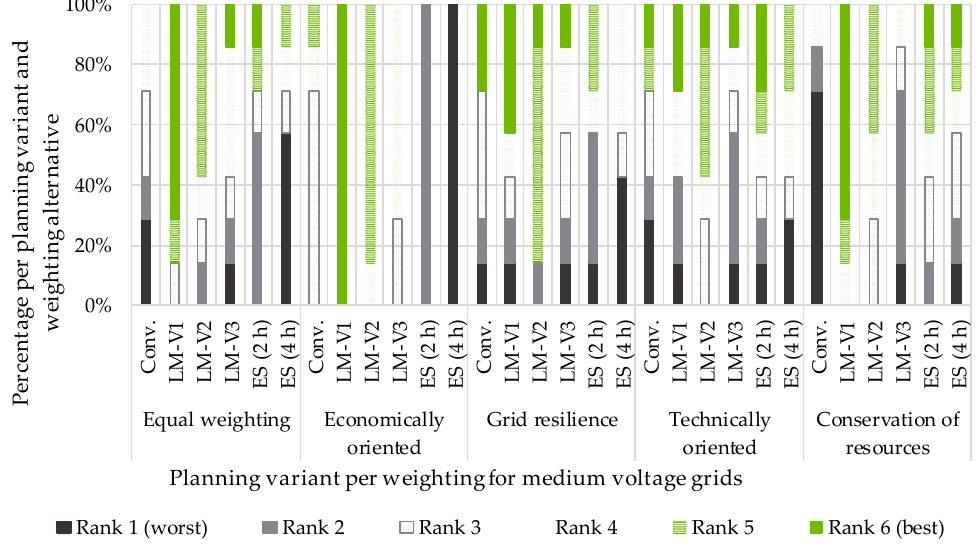
Figure 24. Ranking of the six planning variants according to the weighting alternatives.